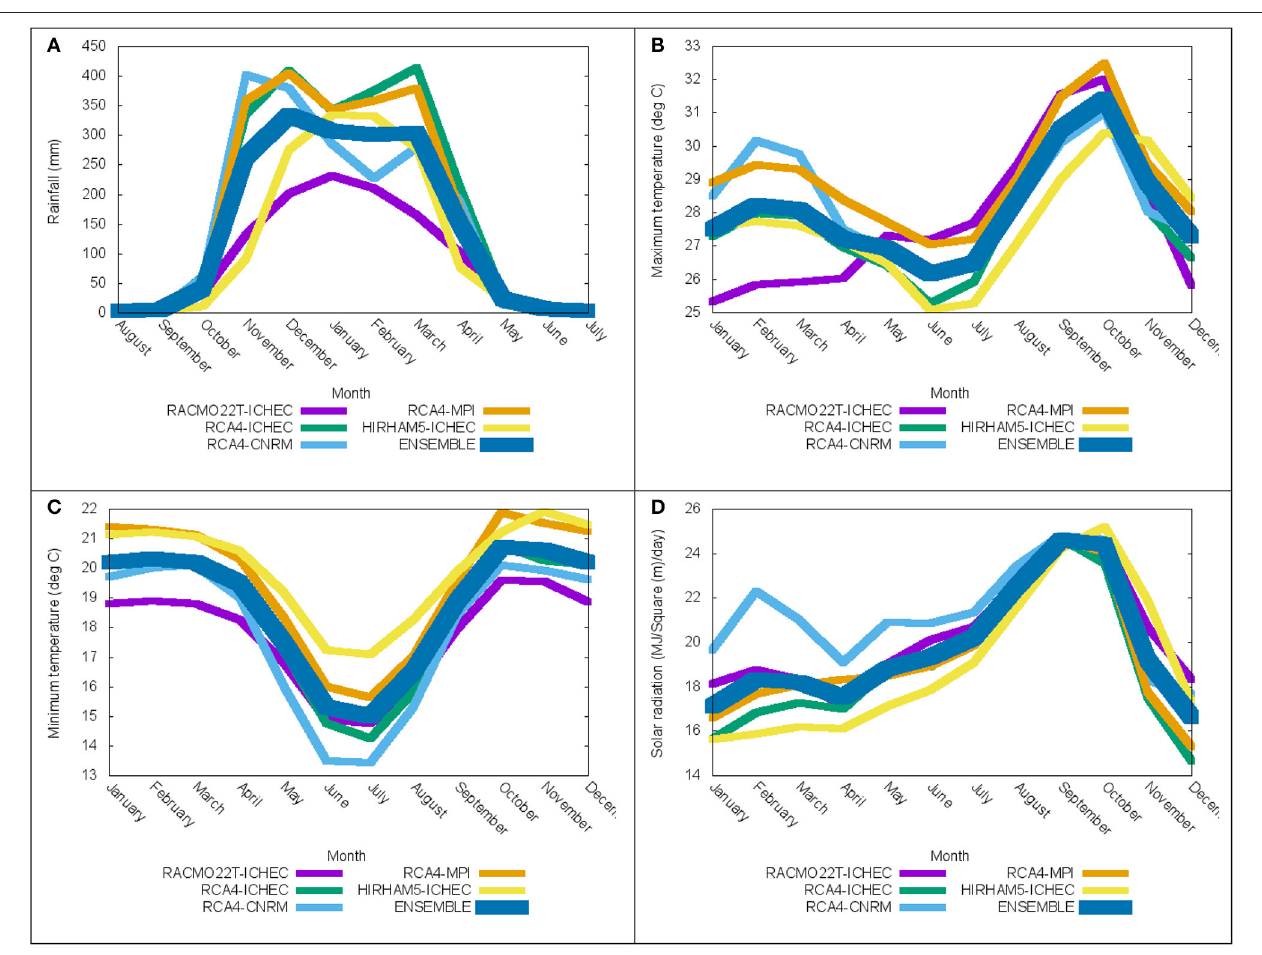
FIGURE 5 | Long-term (2070–2099) annual cycle of climate variables over southern and western highlands sub-agro ecological zones of Tanzania under RCP8.5 (A) rainfall, (B) maximum temperature, (C) minimum temperature, and (D) Solar